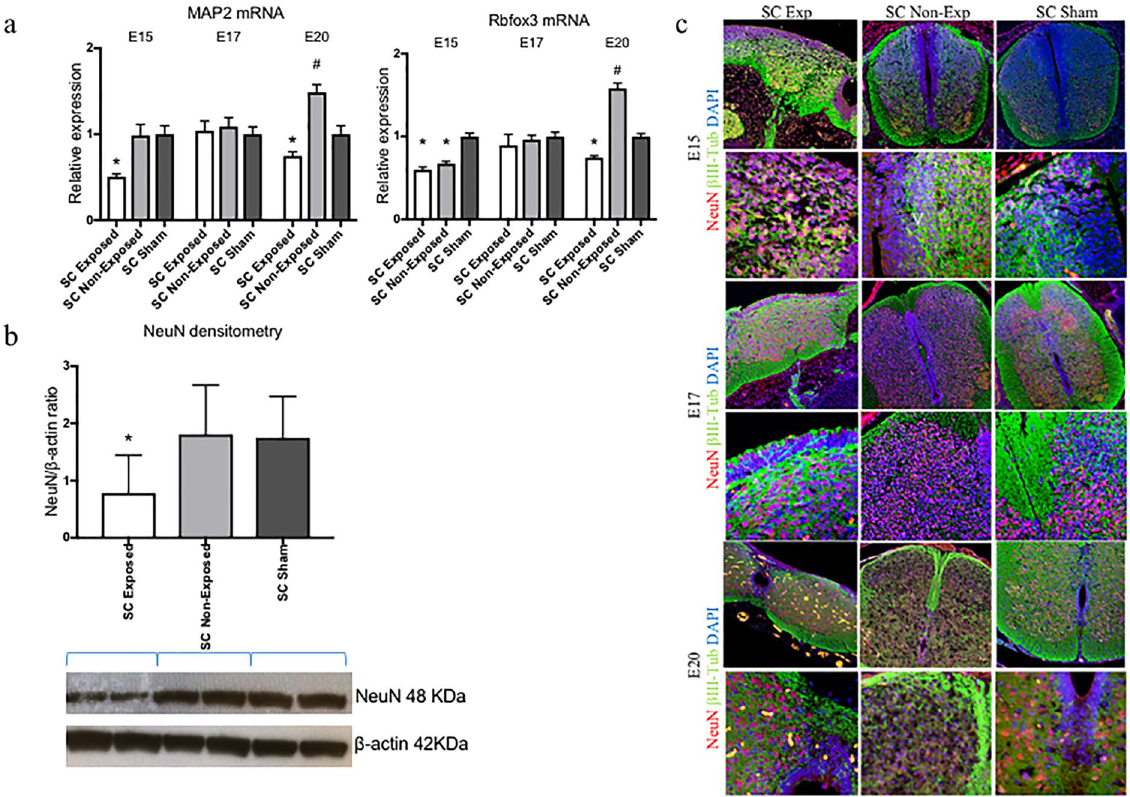
Figure 2. Neuronal expression. ( a ) MAP2 and Rbfox3 gene expression in exposed and unexposed spina bifida cords, and sham spinal cords (SC). Values are means ± SE of relative expression at E15, E17 and E20 for RA-treated (6 fetuses/group) and time-matched controls (6 fetuses/group) ( # and * p < 0.05). ( b ) Western Blot confirmed that NeuN protein expression was reduced at E20 ( * p < 0.05) in spina bifida spinal cords exposed to the amniotic fluid but remained normal in unexposed spina bifida and sham cords. Data (mean ± SD, 6 fetuses/group) of the densitometry ratio and representative cropped bands from the same gel NeuN (48KDa) and β -actin (42 KDa). Relative expression of NeuN normalized to β -actin from spinal cord lysates (mean ± SD 6 fetuses/group). ( c ) β III-Tub (green), Neun (red), and DAPI (blue) immunostaning at E15, E17 and E20 for exposed and unexposed spinal cords in spina (10 × , 40 ×